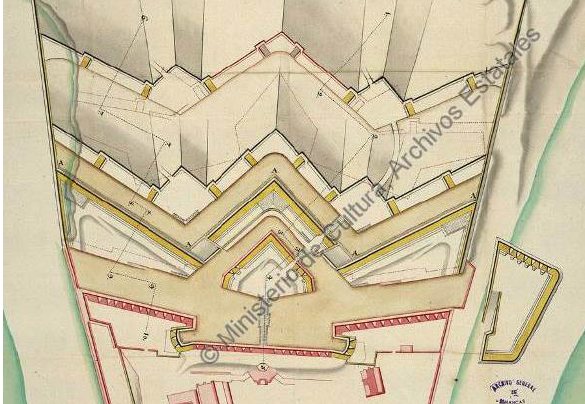
Figure 8. Detail of the project for the Land Front of the Plaza de Cadiz, September 12, 1730. Ignacio Sala. AGS. Secretary of War, file, 03626. Signature MPD,